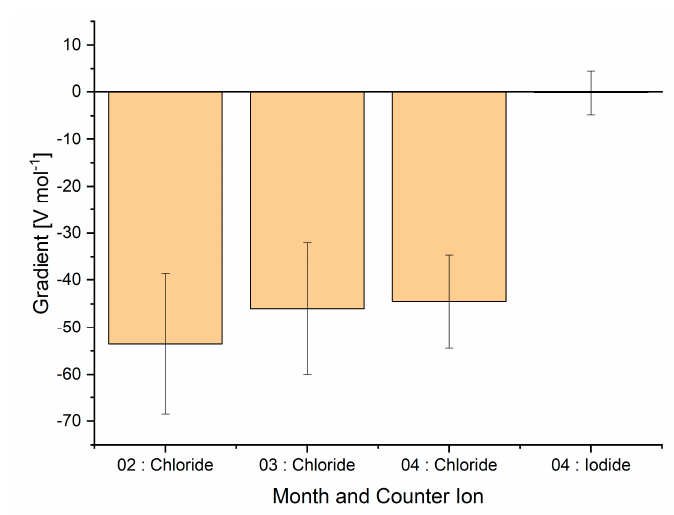
Figure 5. Gradient of the linear regression (y = signal (V), x = salt concentration (mol)). Four different series of measurements are shown, each containing at least nine measurements. Measurements were taken in February, March, and April 2020.